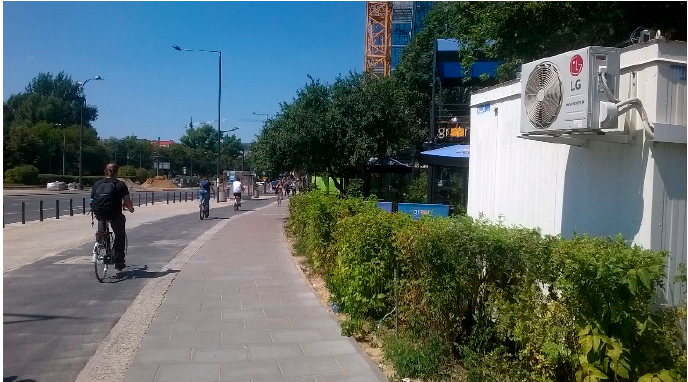
Figure 4. Measuring station at the Daszynskiego roundabout in Warsaw.